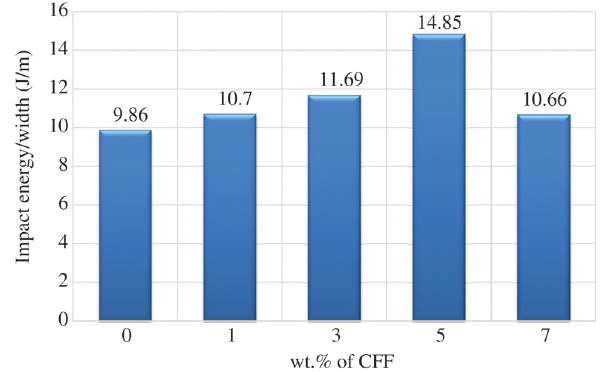
Figure 16: Impact energy/width for various compositions of CFF composite.